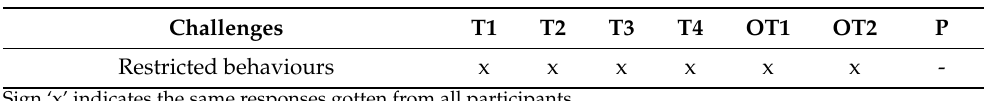
Table 8. Restricted behaviours.